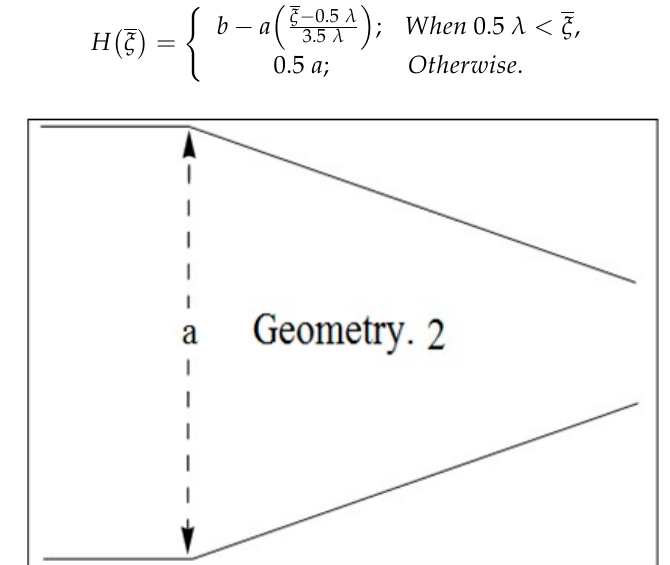
Figure 2. Physical sketch of the geometry.